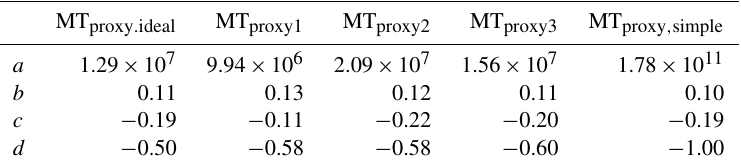
Table 2. Parameters for different proxies.